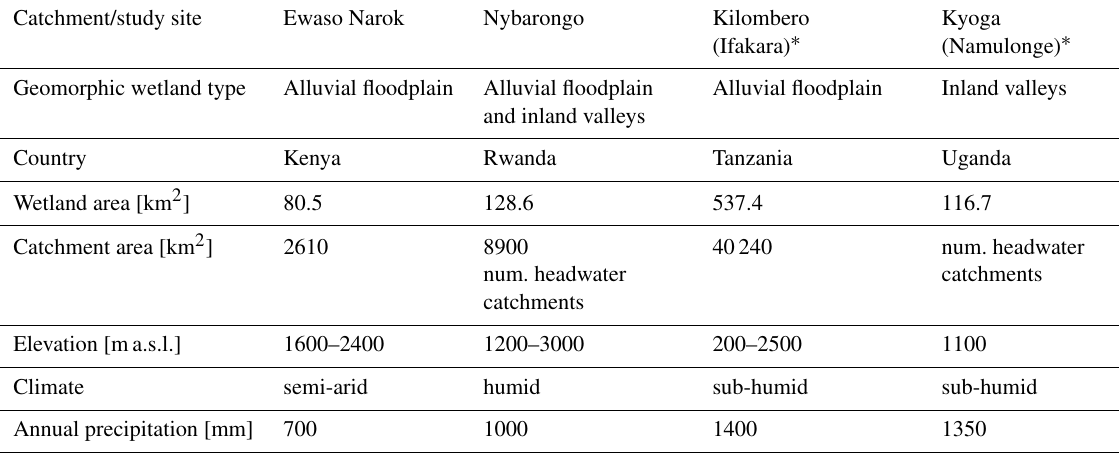
Table 1. Wetland study sites and physical wetland and catchment characteristics, *super test-site of the project. Catchment/study